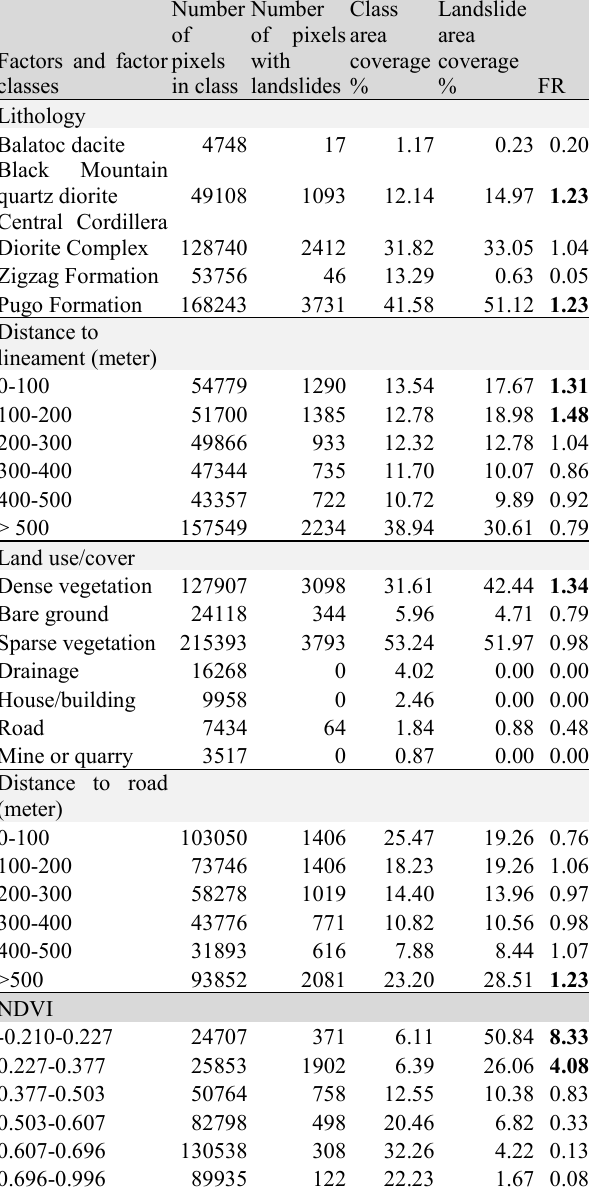
Table 2b. Landslide conditioning factors, factor class